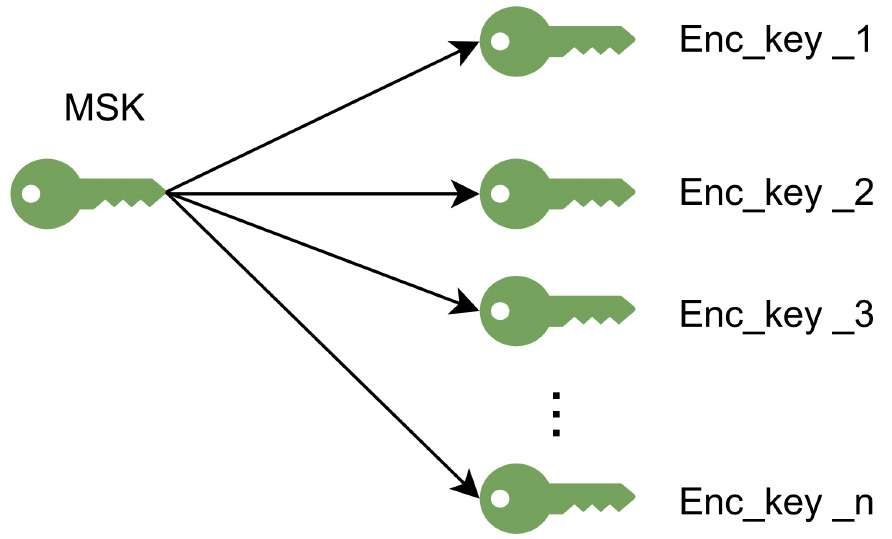
Figure 2. Encryption-Keys